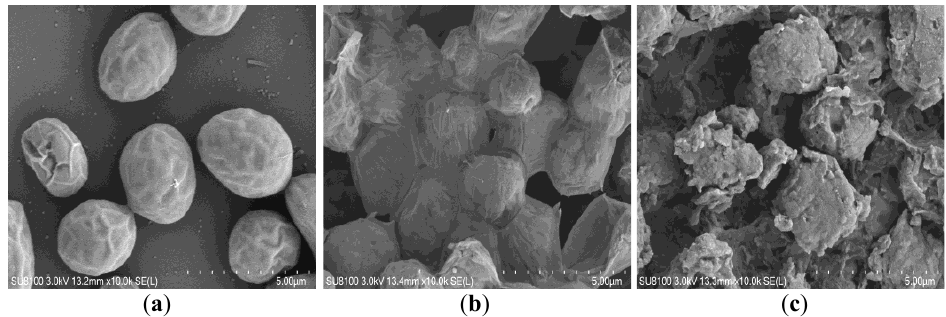
Figure 4. SEM analysis of freeze-dried ( a ), oven-dried ( b ), and wet ( c ) microalgal cells.